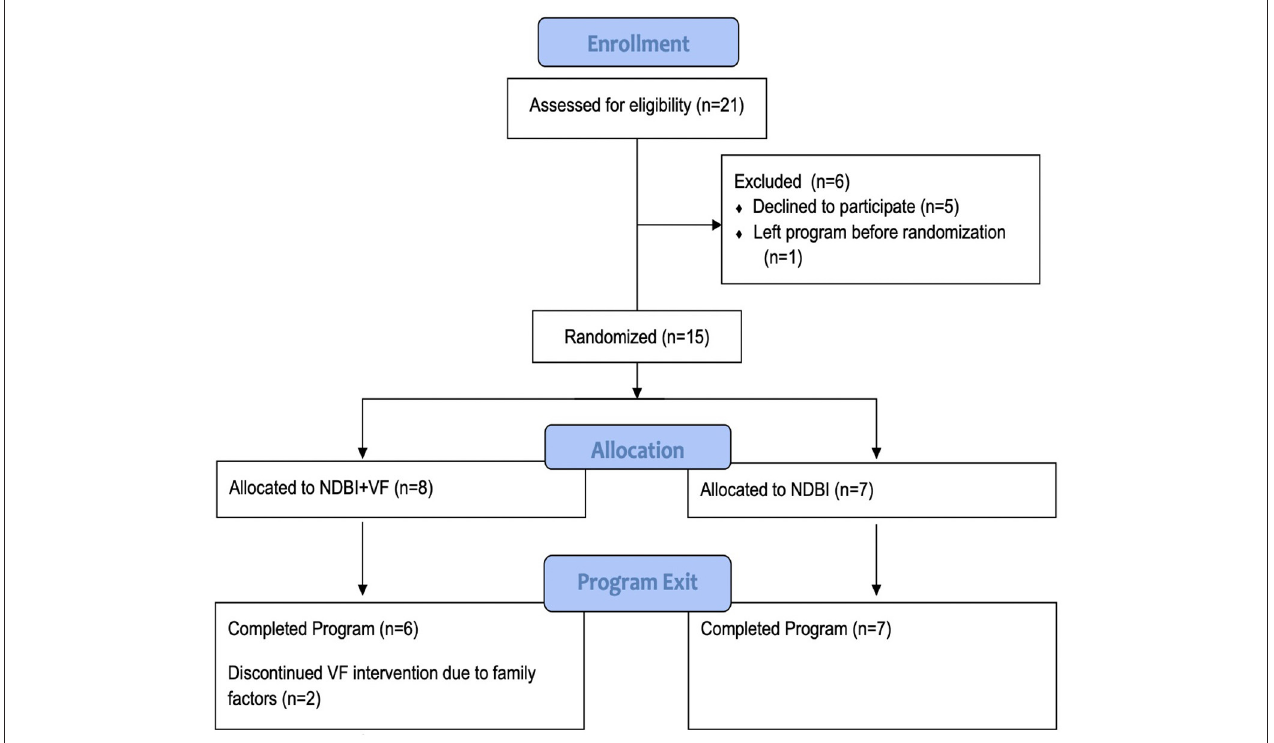
FIGURE 1 | CONSORT